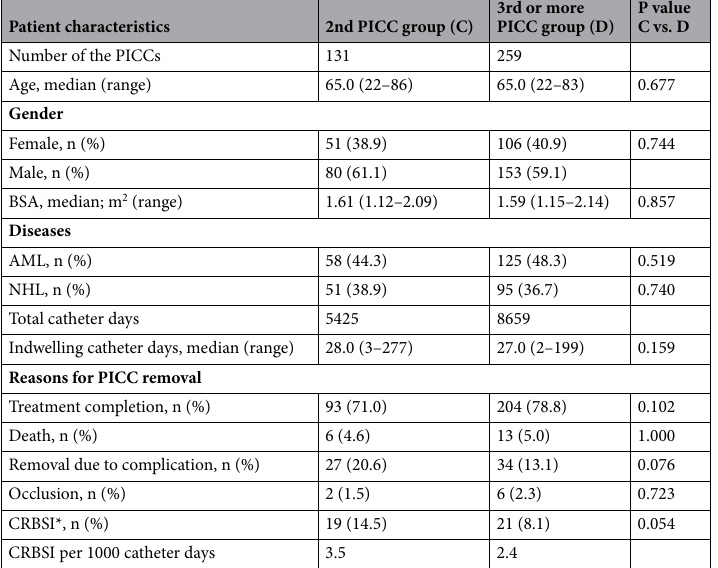
Table 3. Comparison of the PICC groups according to insertion frequency. AML acute myeloid leukemia, BSA body surface area, CRBSI catheter-related bloodstream infection, NHL non-Hodgkin lymphoma, PICC peripherally inserted central catheter. *Even after detection of CRBSI, some patients continued treatment without removal of the PICC, depending on the pathogenic bacteria, patient condition, and responses to antimicrobial agents.